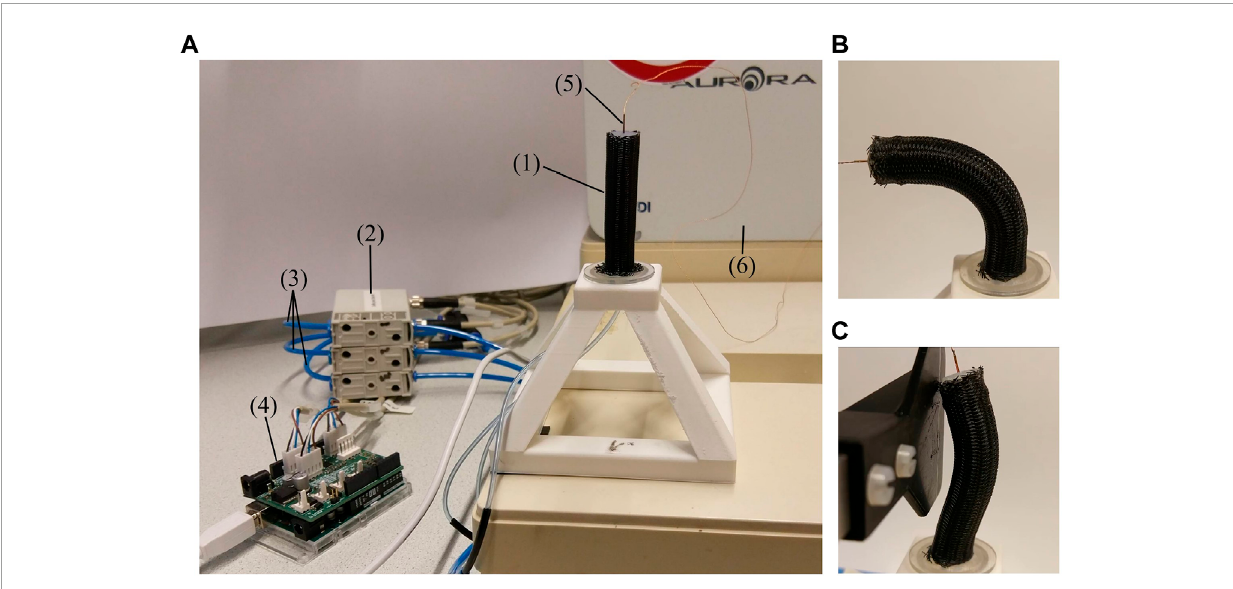
FIGURE 3 The experimental setup (A) for characterization and control of the soft pneumatic endoscope, consisting of: (1) the soft pneumatic module, (2) three pneumatic regulators connected to (3) pressurized air input (2 bar), (4) an Arduino with driver board, and (5) an electromagnetic pose sensor with (6) the EM-field generator. Figures (B) and (C) show the soft pneumatic module during motion and force characterization,